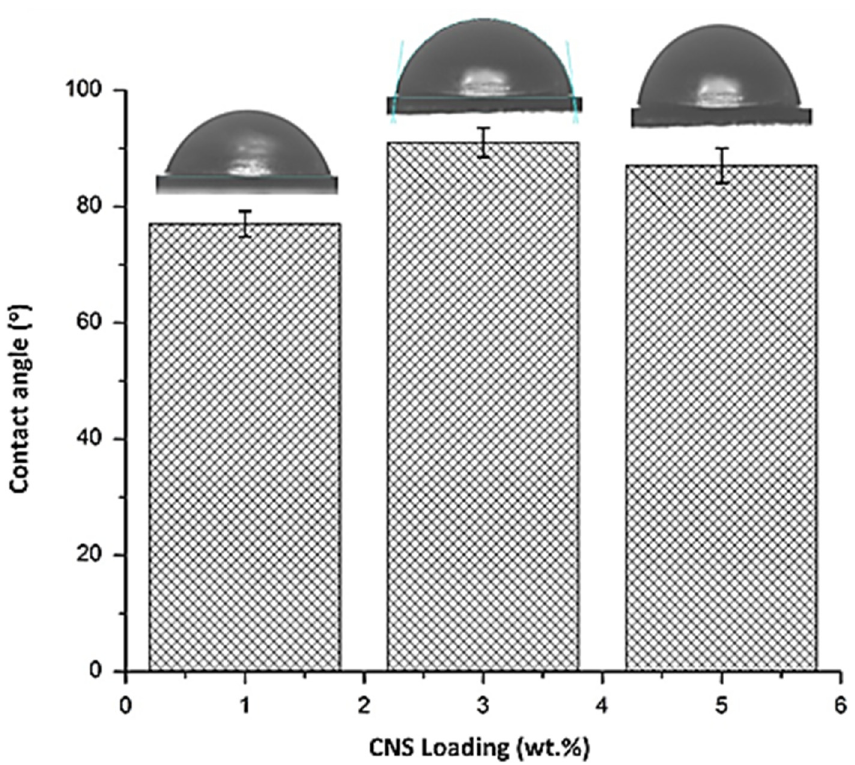
Figure 9. The CNS loading’s impact in casting a solution on the contact angle of the composites’ membrane.